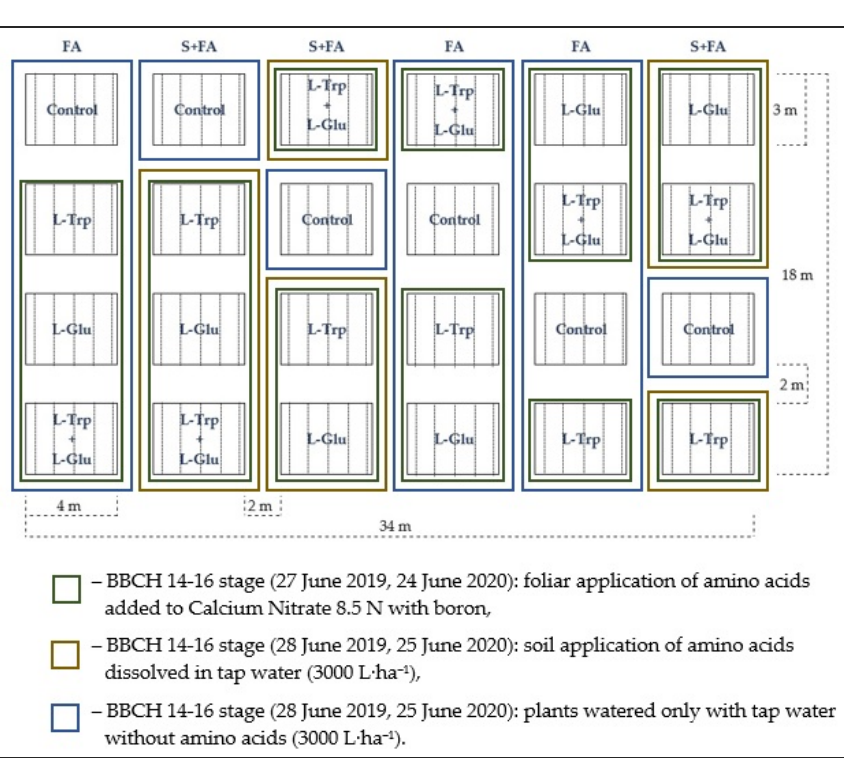
Figure 1. Scheme of the experimental field, FA—foliar application, S + FA—soil and foliar application, L-Trp—L-tryptophan, and L-Glu—L-glutamic acid. Mineral fertilizers were applied to all plots, including the control, at the same doses. First, 12–13 days before sowing seeds, “NPK 14 ‐ 14 ‐ 20 + Mg + S + micronutrients” fertilizer (GA Zak ł ady Azotowe Chorzów S.A., Chorzów, Poland) was applied to the soil at a dose